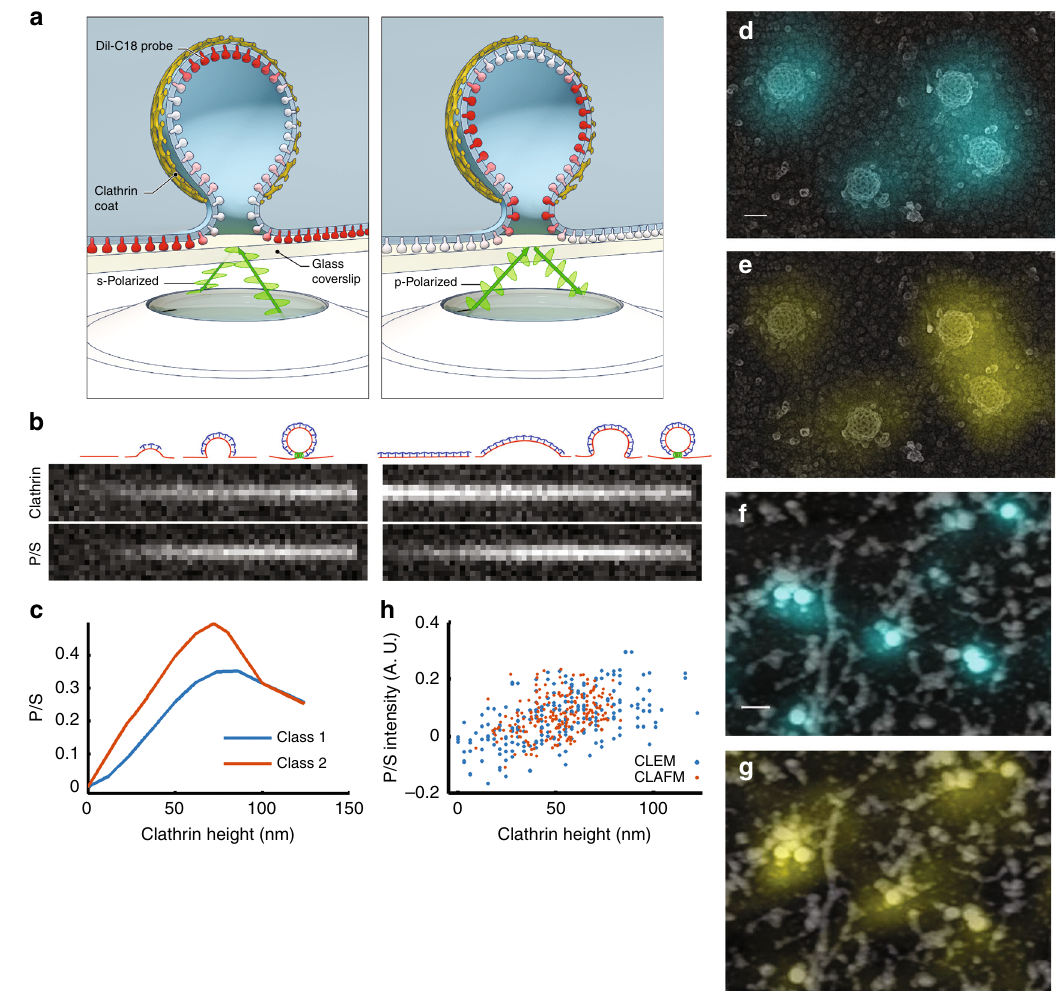
Fig. 2 Polarized-TIRF microscopy enables imaging of membrane bending at clathrin-coated structures. a Schematic representation of pol-TIRF. DiI – C18 orients its dipole moment with the plasma membrane. S-polarized TIRF illuminates horizontal dye molecules, whereas P-polarized TIRF selectively excites vertical dye molecules. The P/S provides contrast for membrane bending. b Simulation of pol-TIRF signals for Class 1 and Class 2 membrane bending. c Quanti fi cation of high-resolution simulation at 10 discrete points for Class 1 (blue) and Class 2 (orange) in the absence of noise. d Correlative TEM-pol- TIRF imaging. Overlay of fl uorescence from endogenous clathrin-Tq2 on the TEM micrograph showing four clathrin structures; scale bar is 100 nm. e Overlay of P/S on the same region of the micrograph. f Correlative AFM-pol-TIRF imaging; Overlay of clathrin-Tq2 on AFM micrograph; scale bar is 250 nm. g Overlay of P/S signal on the same region of the AFM micrograph. h Quanti fi cation of P/S intensity and heights from correlative tomographic reconstructions (blue), and AFM